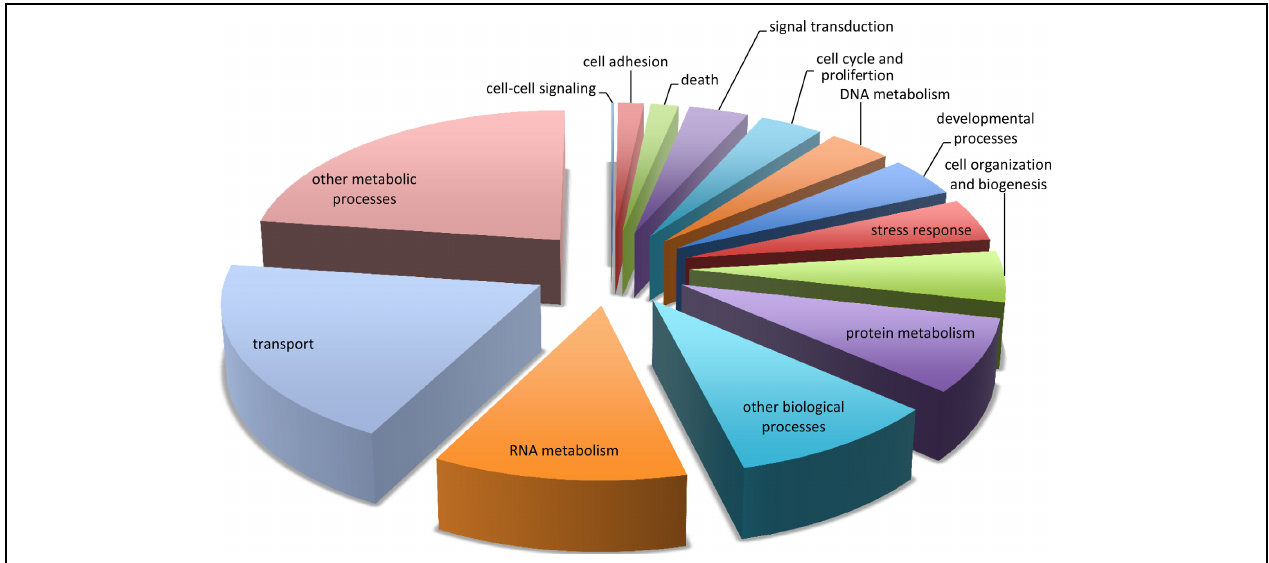
FIGURE 1 | Functional categorization of the sea fan transcriptome. Functional categorization of contig sequences from de novo assembly of both libraries using Gene Ontology (GO) biological process “GO slim” classification.